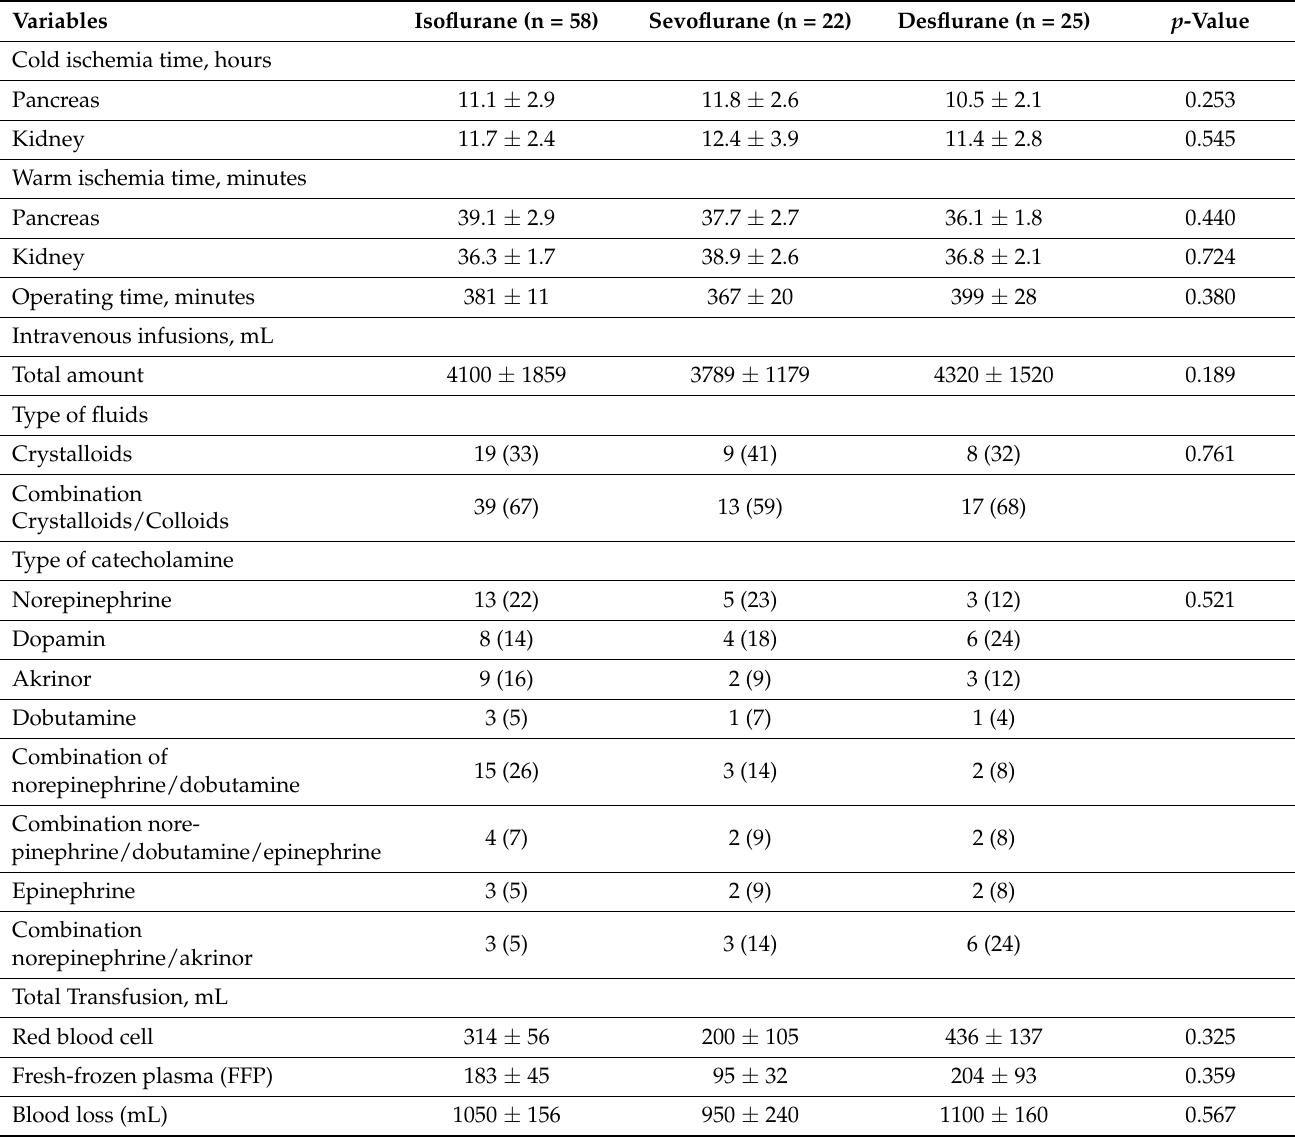
Table legends: FFP, fresh frozen